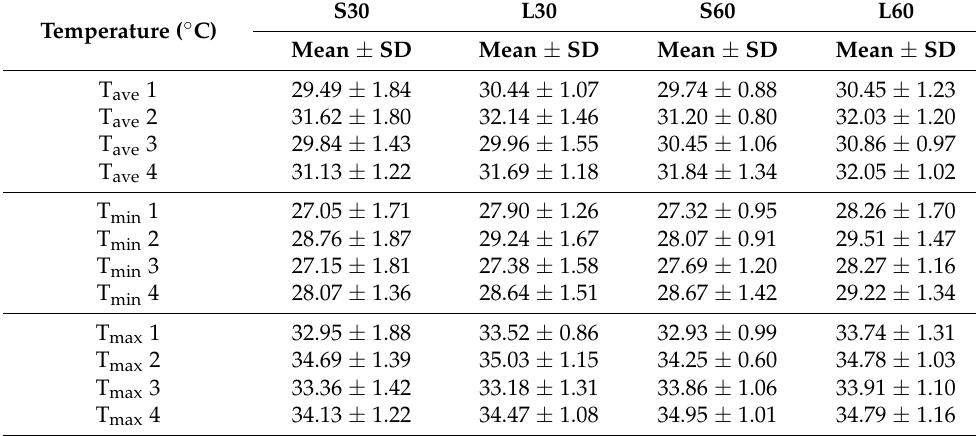
Table 3. The average, minimum, and maximum values of the surface temperatures of the buttocks and thighs recorded during subsequent measurements during vibration